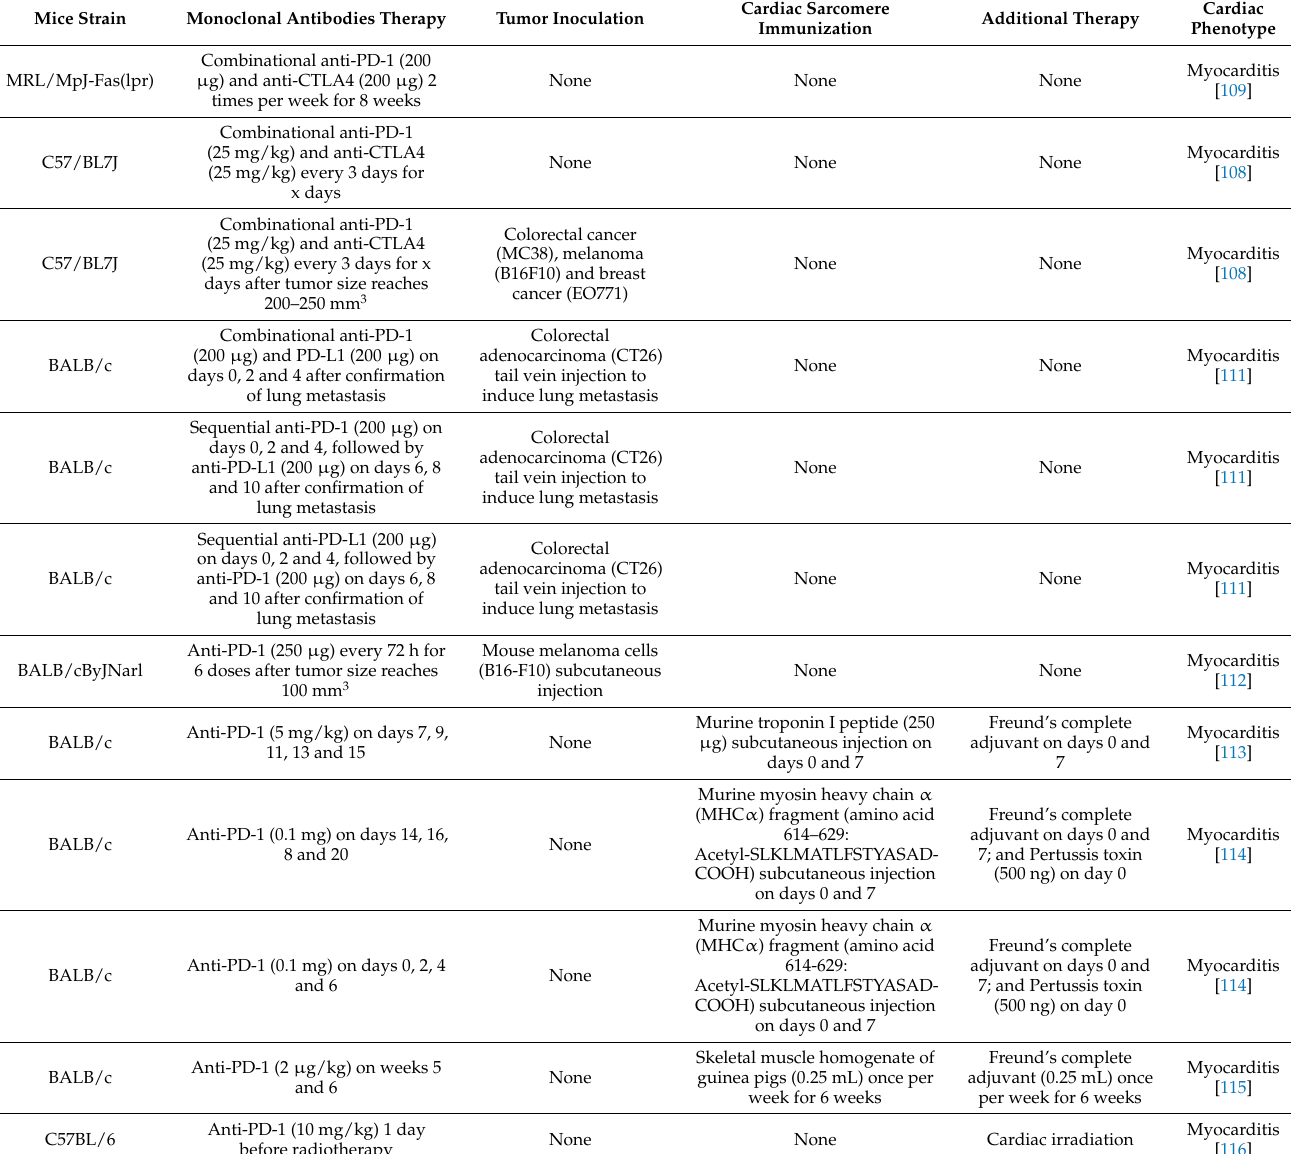
Table 4. Immune Checkpoint Inhibitor Monoclonal Antibodies for Myocarditis